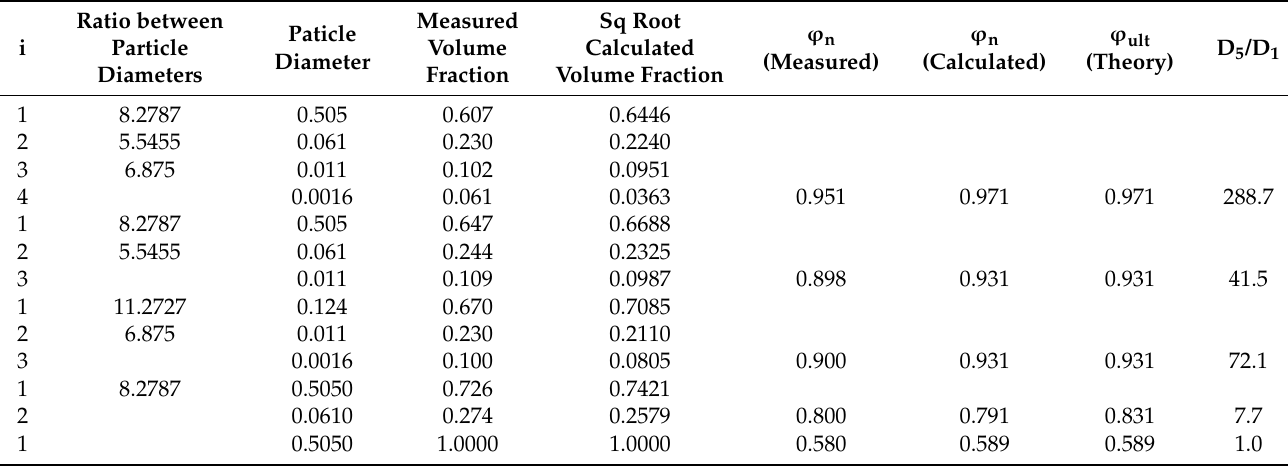
Table 1. McGeary’s experimental data with calculations from Sudduth